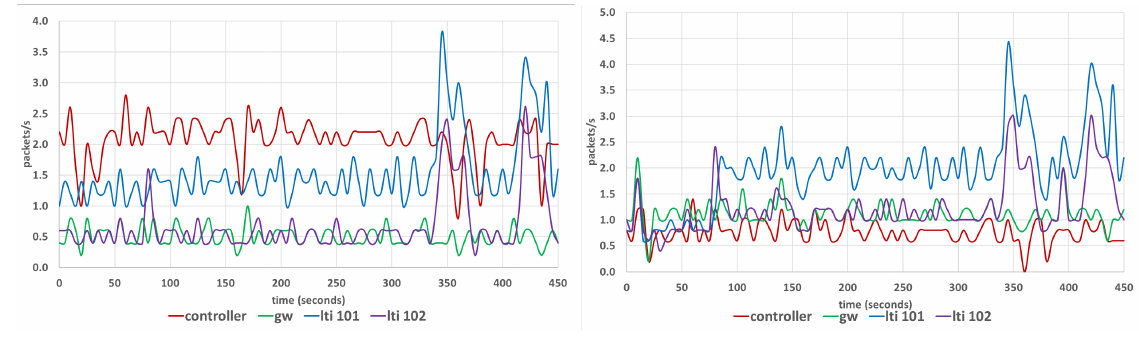
Figure 8. Testing Connectivity